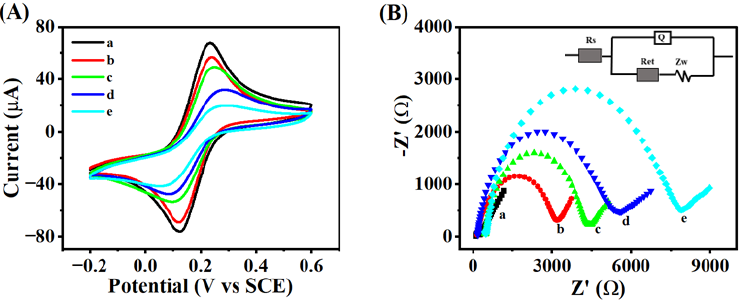
Figure 4. Electrochemical characterization of the preparation process of sandwich immunosensors: ( A ) CV and ( B ) EIS of (a) bare GCE, (b) Ab 1 /Au/GCE, (c) BSA/Ab 1 /Au/GCE, (d)